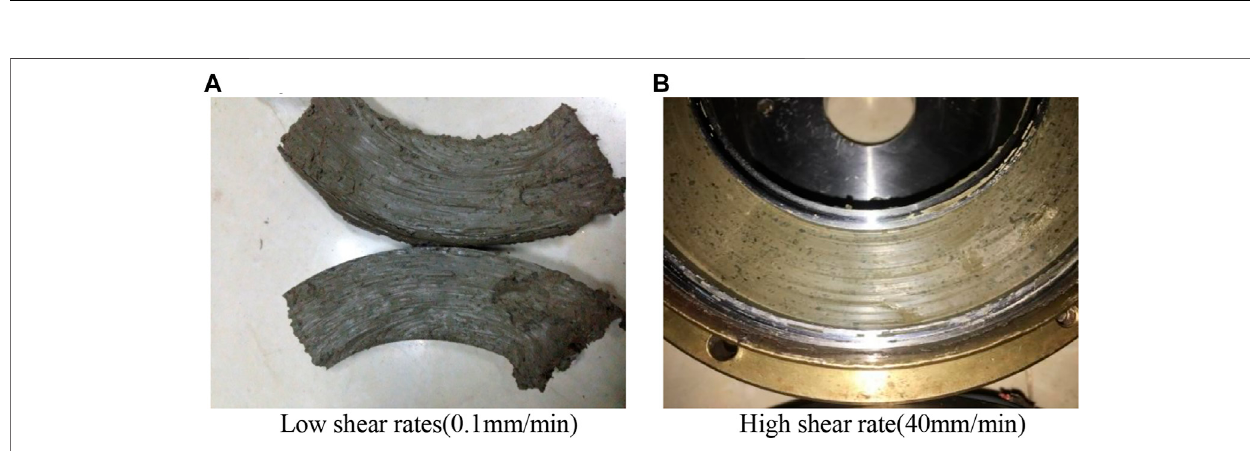
FIGURE 9 | Failure surfaces of clayey interlayer sliding soil samples with different shear rates(400 kPa). (A) Low shear rates(0.1 mm/min). (B) High shear rate (40 mm/min).